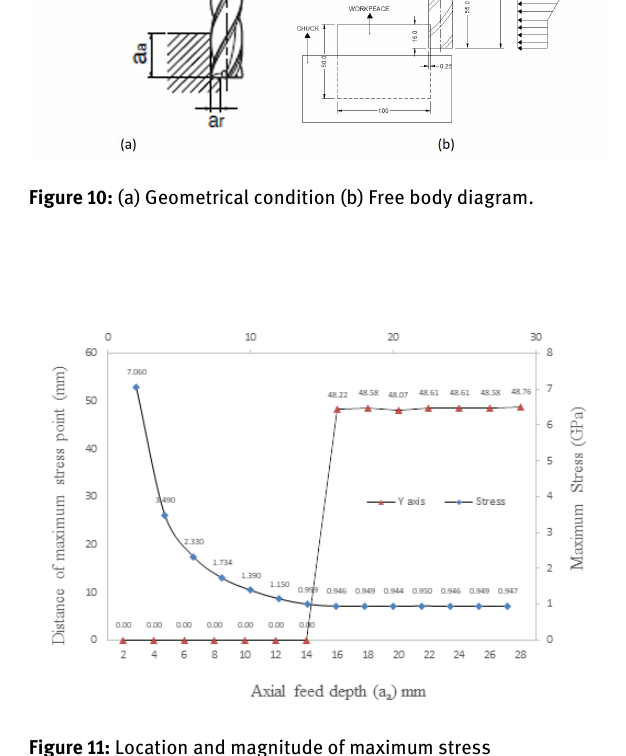
Figure 11: Location and magnitude of maximum stress